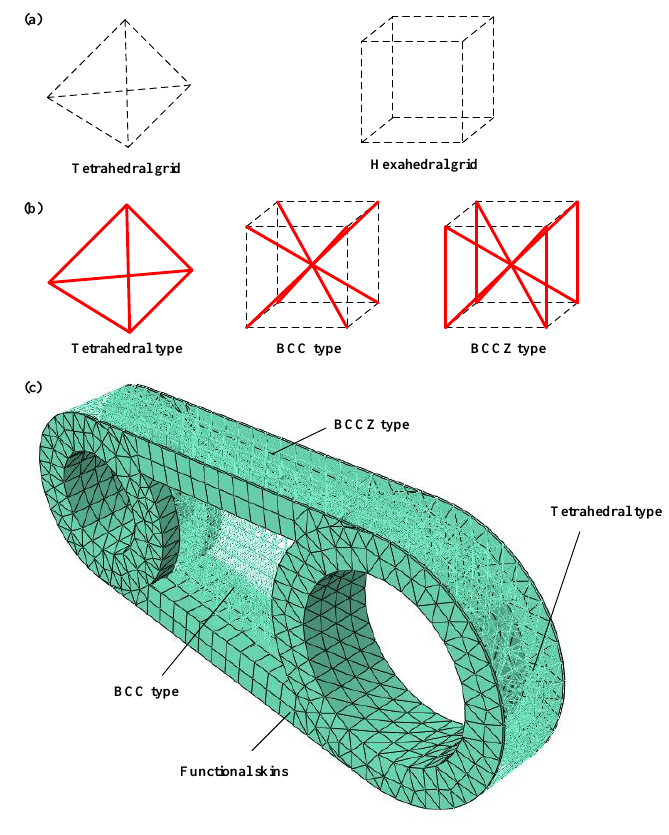
Figure 11. Combinations of various spatial grids and lattice cells. ( a ) Spatial grids; ( b ) Lattice cells; ( c ) Lattice